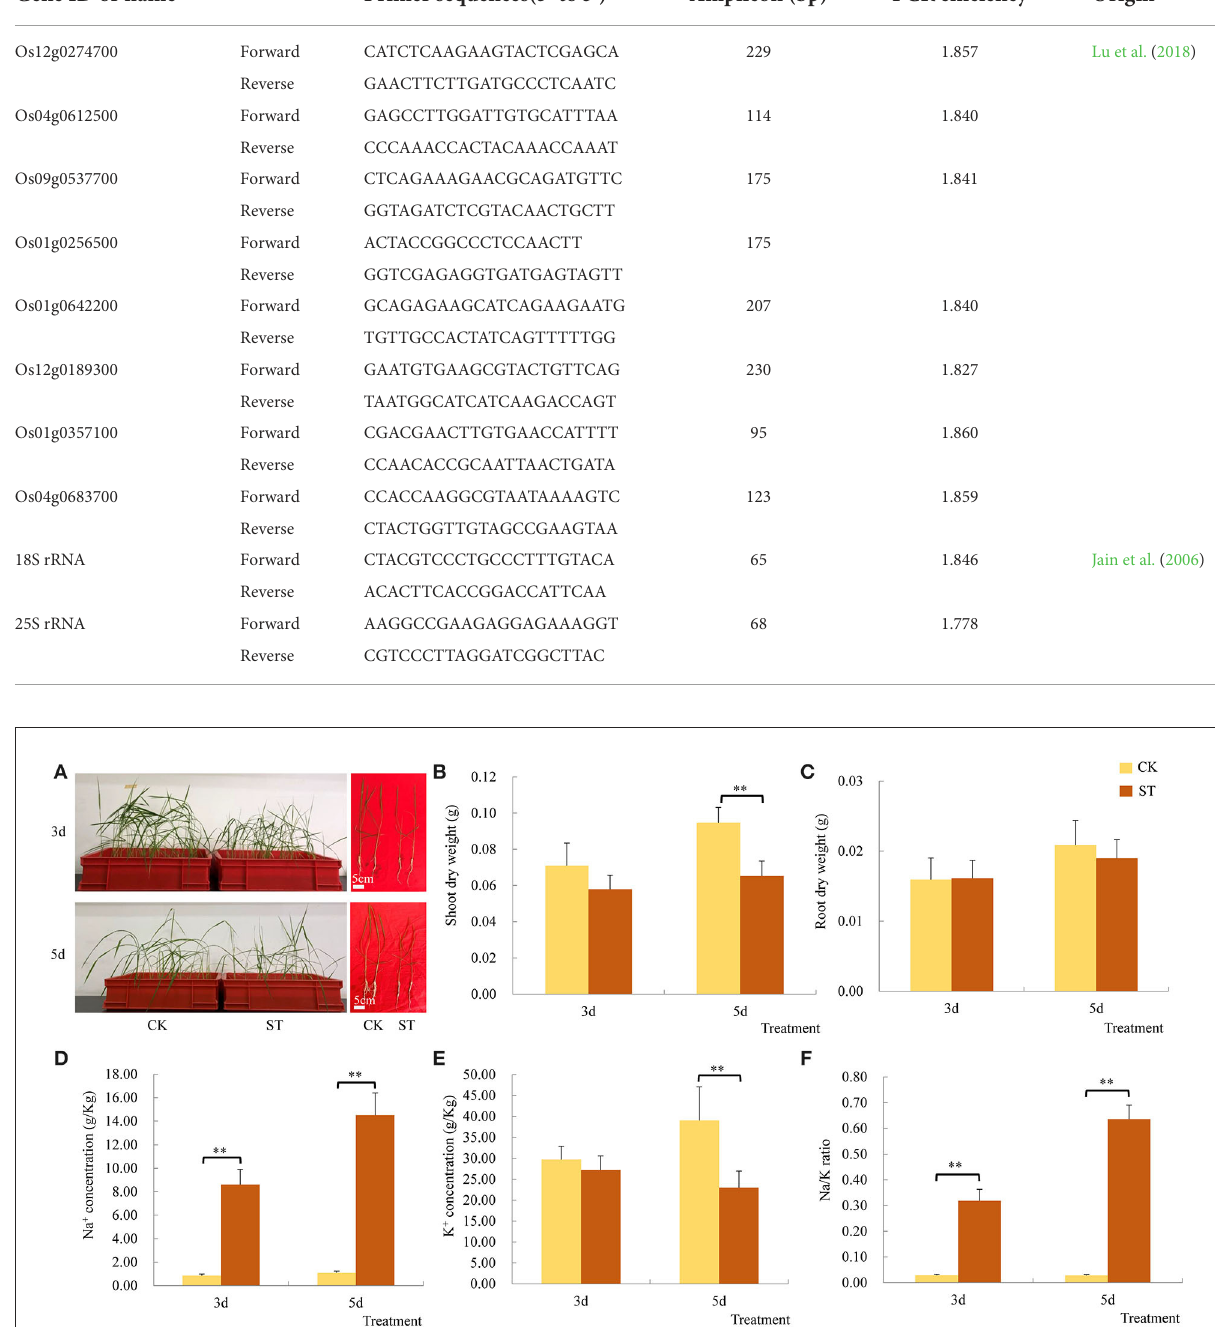
and K + content (SKC) are expressed as grams of sodium and potassium per kilogram of shoot dry weight in each sample